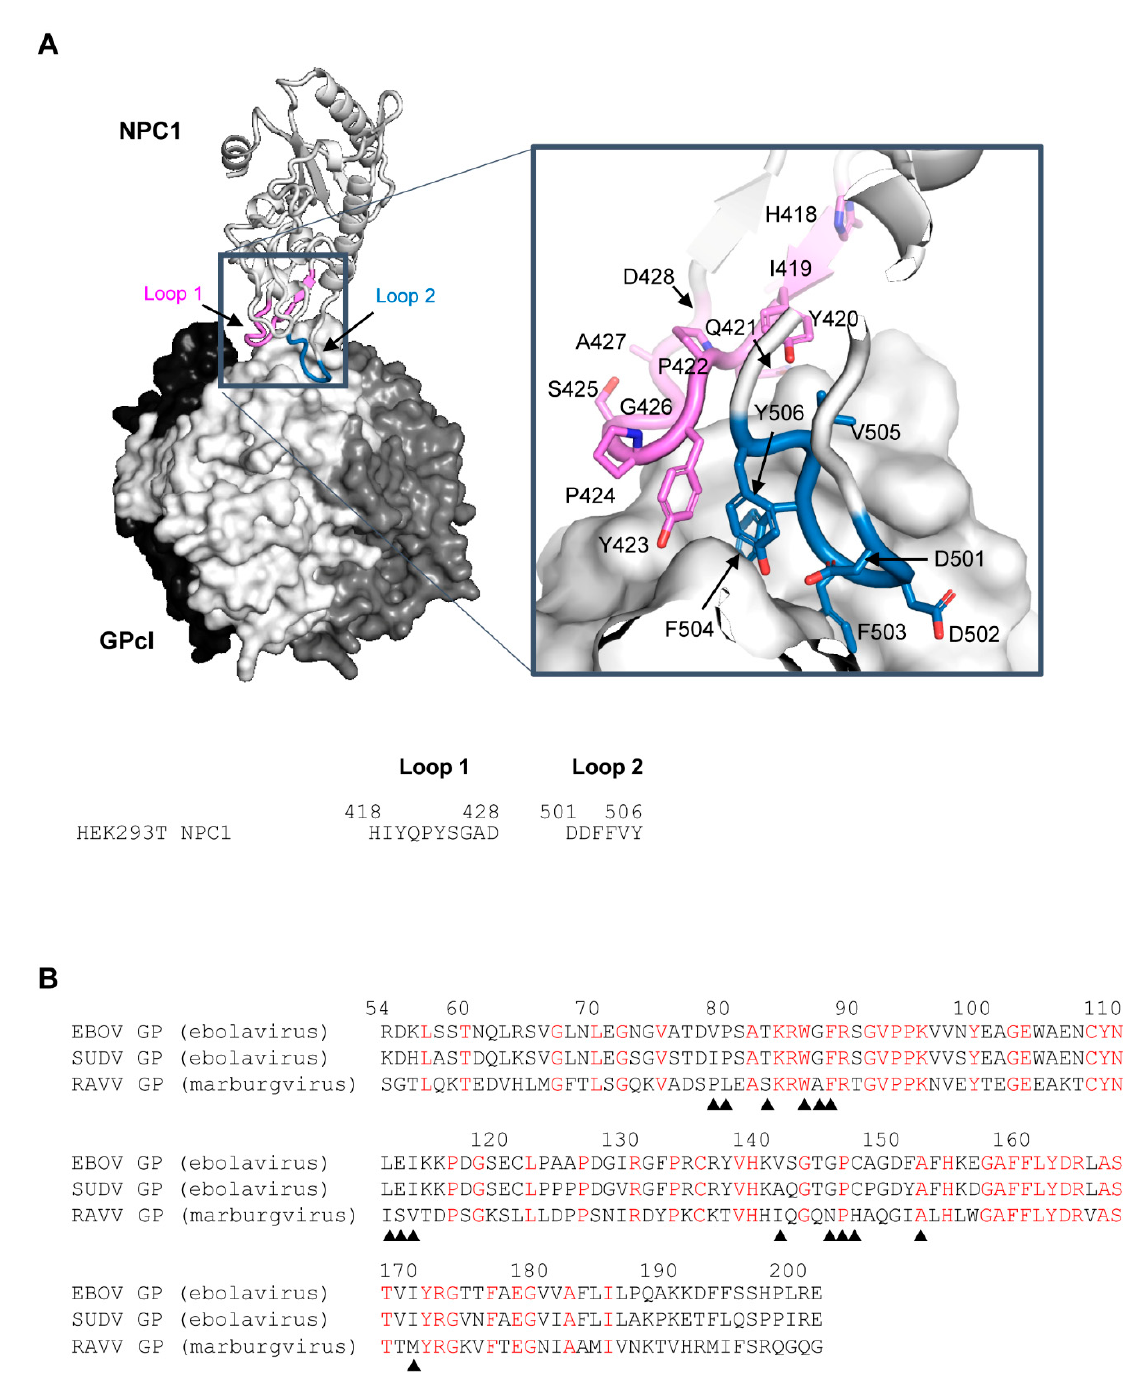
Figure 1. Three-dimensional structure of the EBOV GPcl–NPC1 complex and amino acid sequences of the receptor-binding domain of EBOV, SUDV, and RAVV GPs. ( A ) The three-dimensional structures of EBOV GPcl trimer and human NPC1-C (PDB ID: 5F1B) are represented as a surface and a ribbon model, respectively. On the GPcl trimer, one monomer (center) is colored white and the others are colored black and dark gray. The GPcl-binding interface, including NPC1 loop 1, and loop 2 (indicated in violet and sky blue, respectively), is shown in the boxed areas. Nitrogen and oxygen atoms are shown in blue and red, respectively. The amino acid residues of loop 1 and loop 2 in NPC1 are displayed. ( B ) Three receptor-binding domain sequences of filovirus GPcl were aligned using EBOV numbering. Conserved amino acid residues among EBOV, SUDV, and RAVV GPs are shown in red. Solid triangles indicate the positions of contact residues of EBOV GPcl with NPC1 observed in the crystal structure.